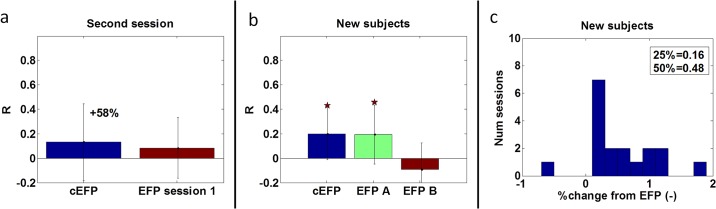
Comparison between the cEFP and the EFP performances.a) Depicts the performance of the individual model constructed for the first session when testing on the second session. It compared with the cEFP performance on the same sessions. The results are an average over subjects whose first session was included in the common model construction process (n = 9). b) Compares the cEFP performance with the performance of two ‘optimal’ EFPs, when applied to a group of new subjects (n = 18, 9 subjects). In Fig 5a and 5b, the star's color represents the method that obtained significance (*p < 0.05). The error bars are standard deviations over sessions. c) Depicts the cEFP percentage change histogram (relative to EFP).